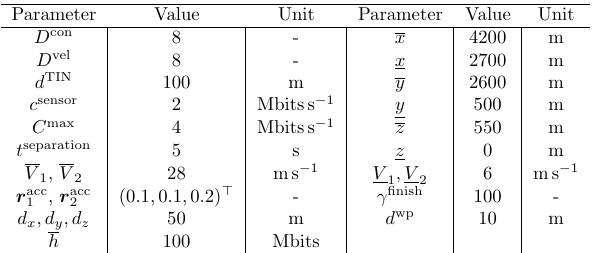
Table 1: Tasks, and coordinates of their corresponding waypoints of Scenarios 1 and 2